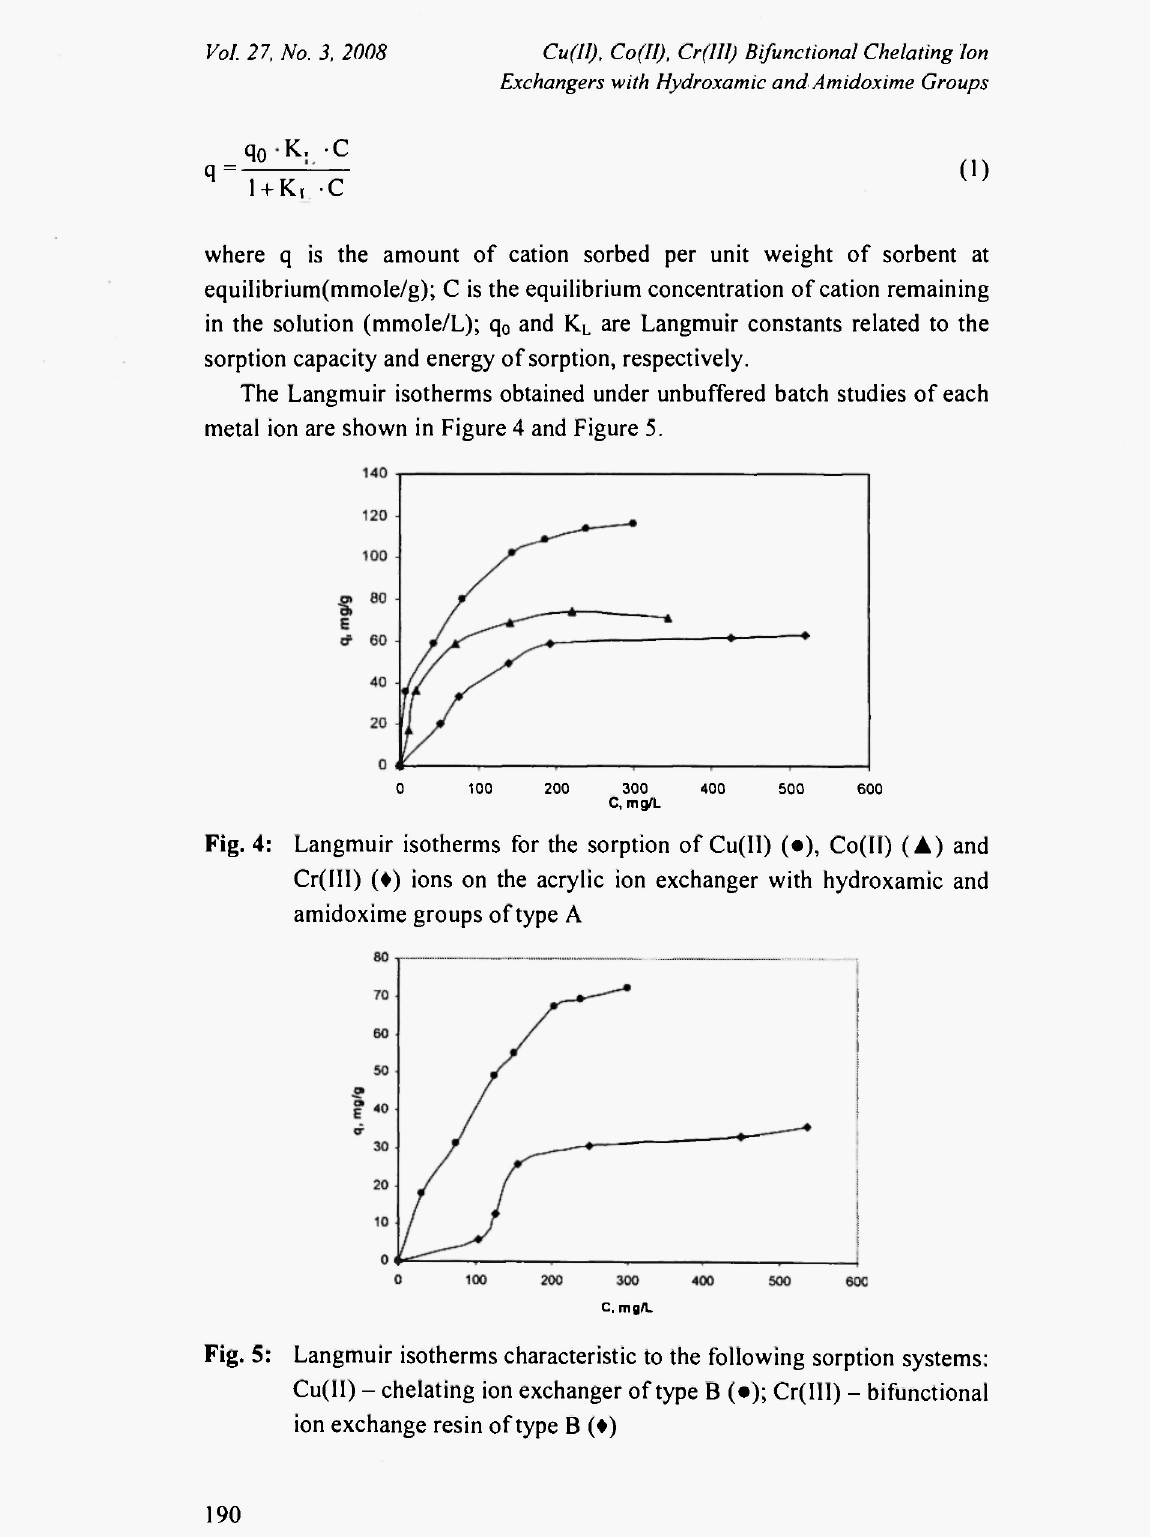
C, mg/L Langmuir isotherms characteristic to the following sorption systems: ion exchange resin of type Β